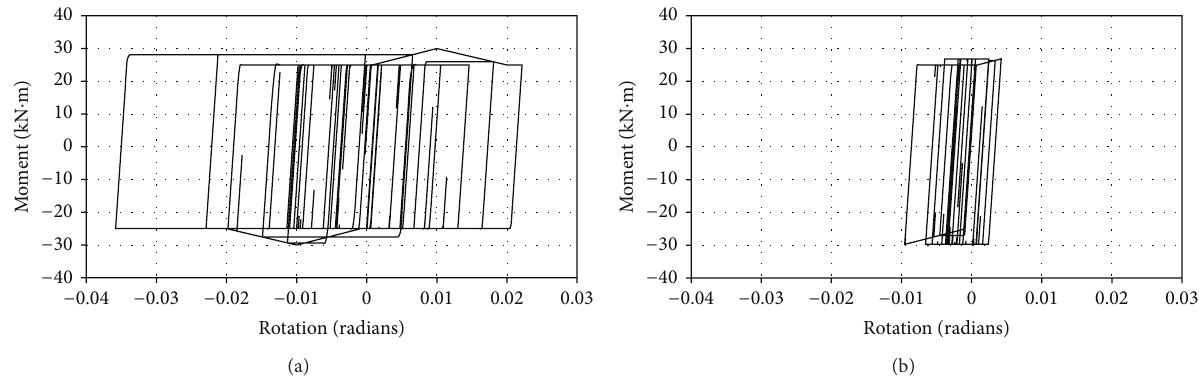
Figure 8: Spherical bearing response at the south abutment for (a) curved transverse direction and (b) skewed transverse